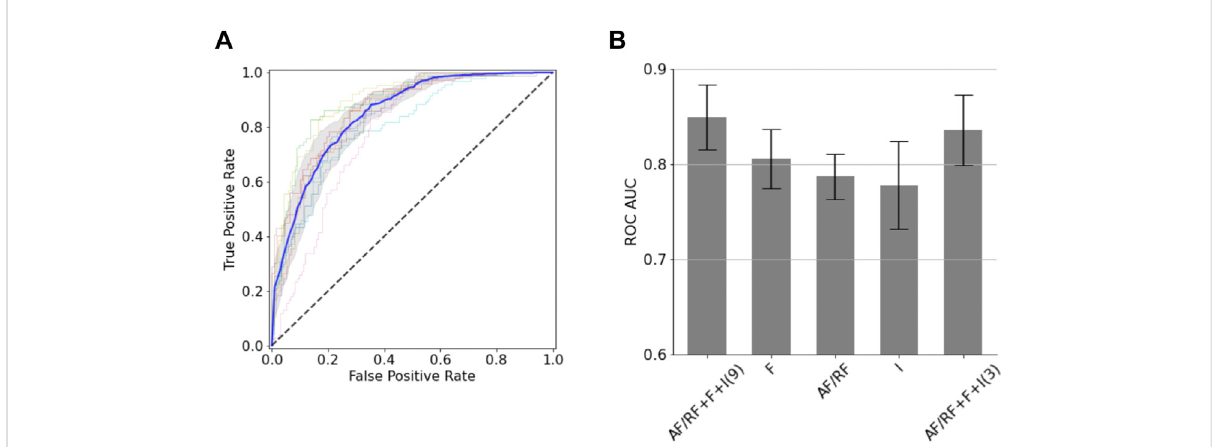
FIGURE 2 Classi fi cation models for the BoNT dataset. (A) ROC curves obtained from the 10-fold cross validation. The average ( blue line ) and standard deviation ( gray shadedarea )ofthe10ROC curves isshown. (B) AUC ROCvaluesfor classi fi cationmodelsusing differentsets ofdescriptors ( “ AF/RF ” : 3descriptorsobtainedfromAForRF; “ F ” :2fragmentqualitydescriptors; “ I ” :4interfacedescriptors).ThenumberofdescriptorsusedinthetwoAF/RF + F + I models is shown in